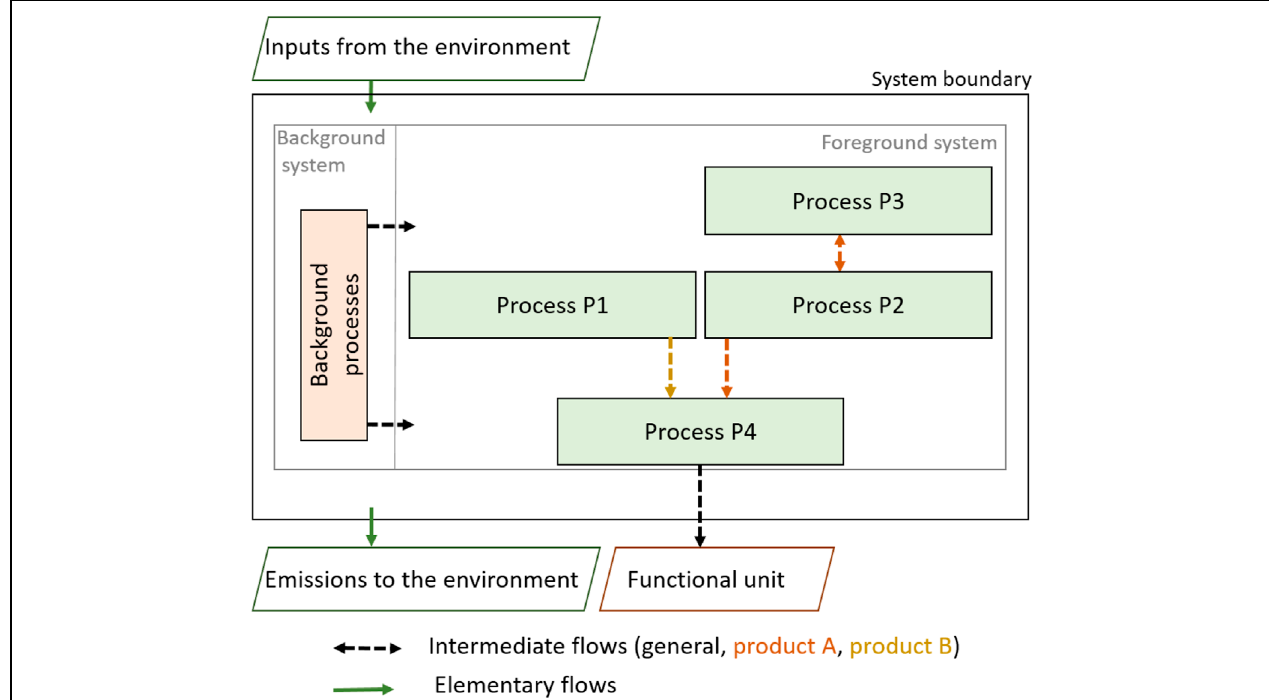
FIGURE 2 | Functional unit and system boundary of a generic multi-sector